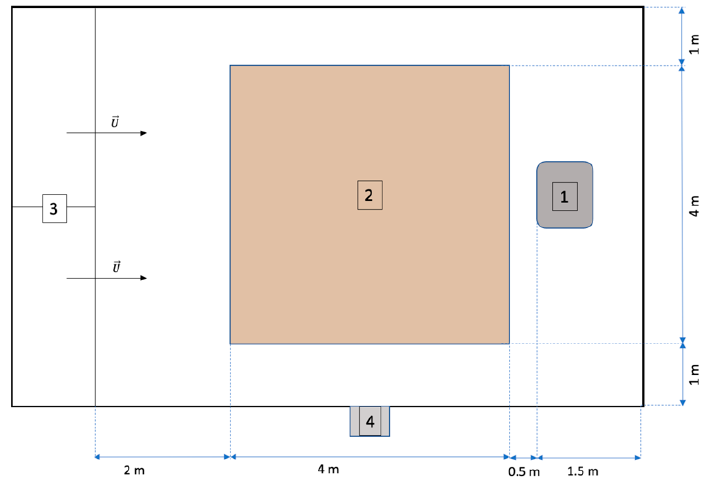
Figure 4. Experimental setup (1—telecommunication cabinet, 2—fuel bed, 3—wind tunnel fans, 4—infrared and video cameras).